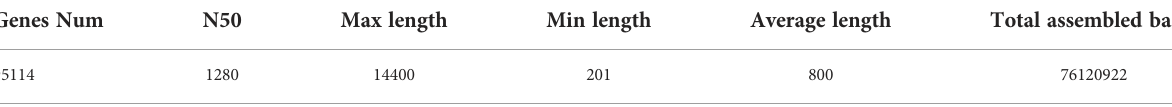
TABLE 2 De novo assembly